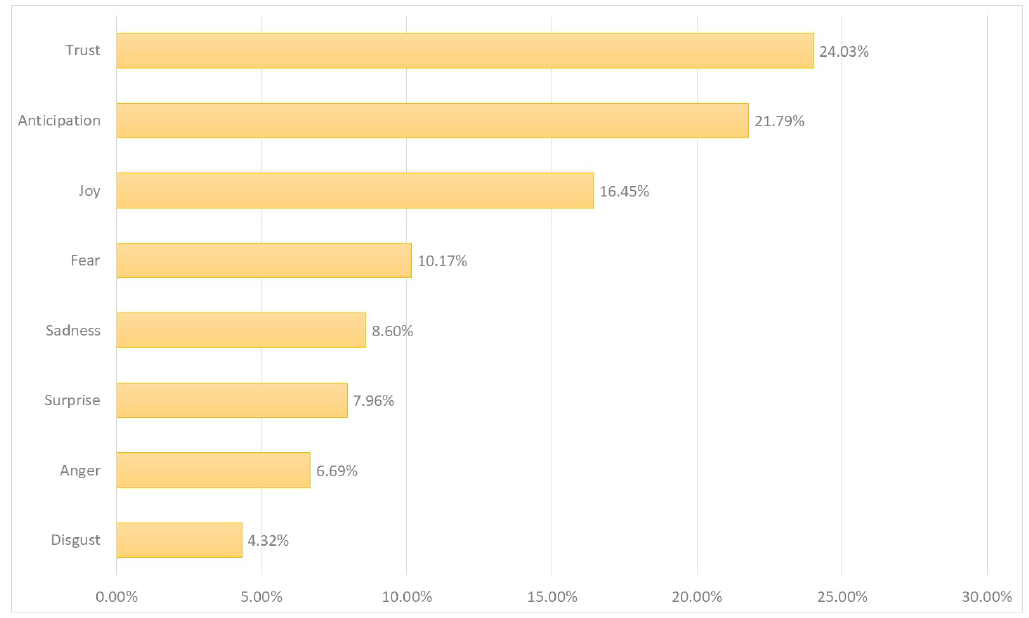
Fig. 1. Sentiment Analysis of Tweets for Work from